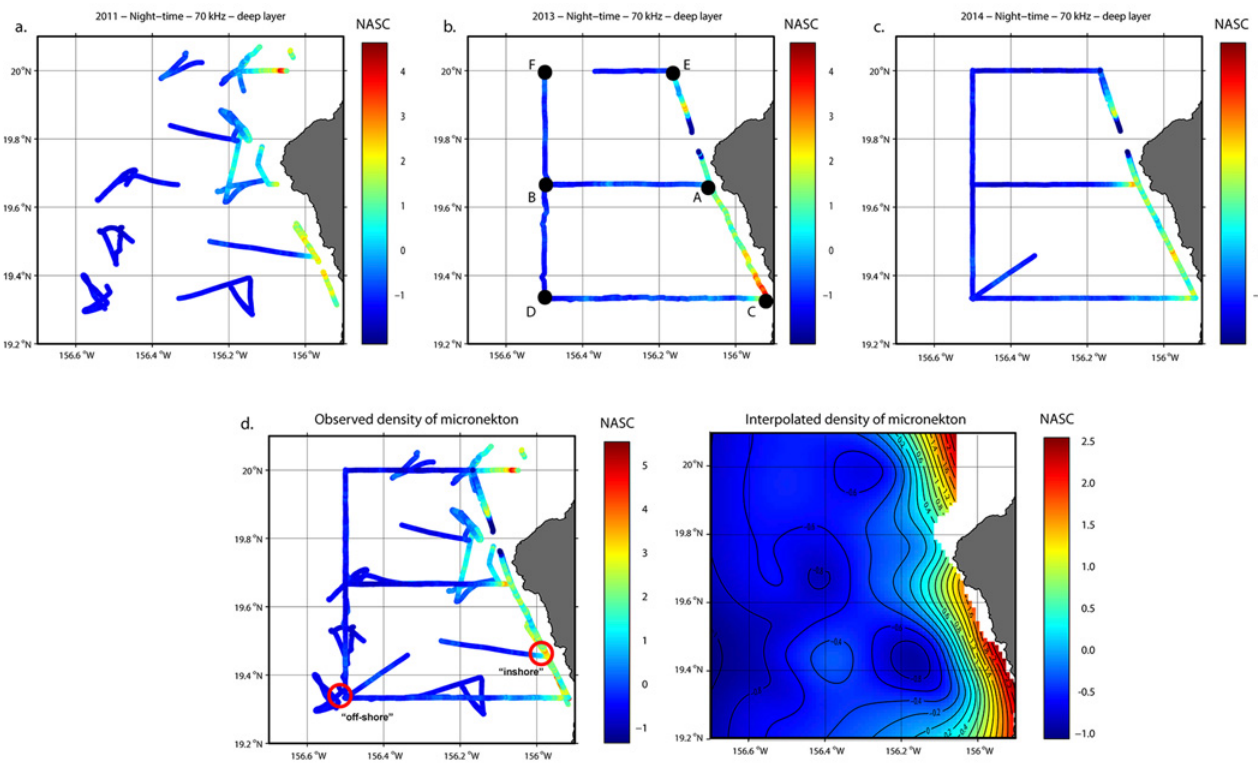
Fig 4. Micronekton distribution. Observed density of micronekton along 2011, 2013, 2014 cruise transects (a – c, respectively), all 3 cruises combined with the “ hotspot ” and “ off-shore ” sites circled (d) and corresponding predicted density of micronekton over the study area from the GAM (lon,lat) (e). Values shown here are standardized NASC values for 70 kHz deep night-time. The lettered black dots on Fig 4B represent the 2013 trawling stations.